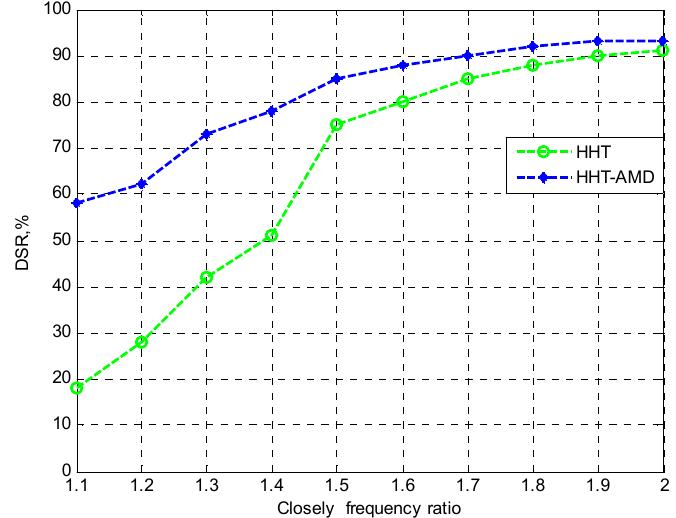
Figure 8. The comparison of DSRs (decompose success rates) against close-frequency ratio between HHT and HHT-AMD .